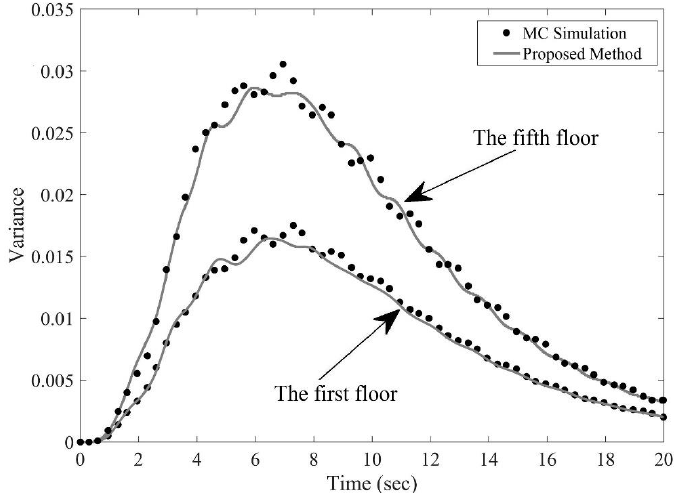
Figure 16. Mean square displacement response of a 5DOF Duffing–Van der Pol system under nonstationary excitation. ( γ = 10.0, µ = 1.0).